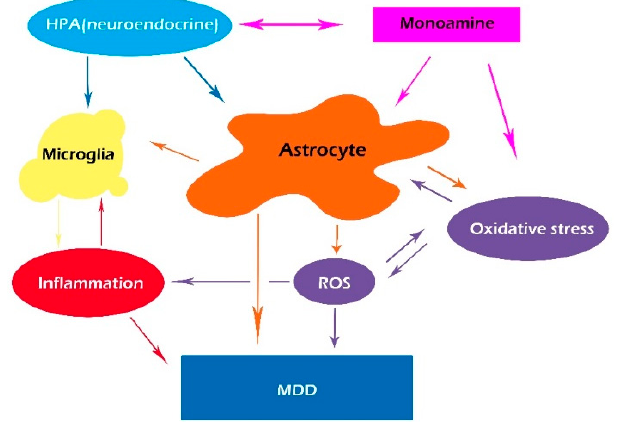
Figure 2. An integrative hypothesis suggesting that the glymphatic system integrates monoamine transmission with dysregulation in neuroendocrine systems, together with oxidative stress and induced immunological alterations in MDD.